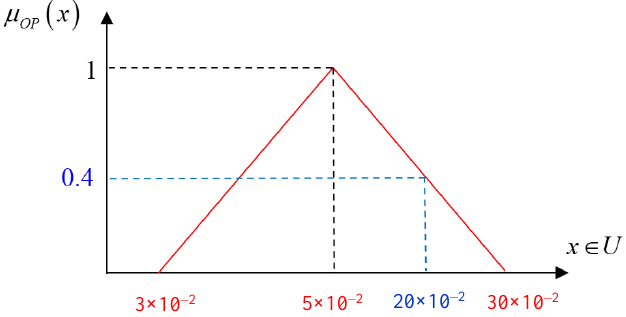
Figure 2. Example for a membership function for the category Occurrence Probable (OP).